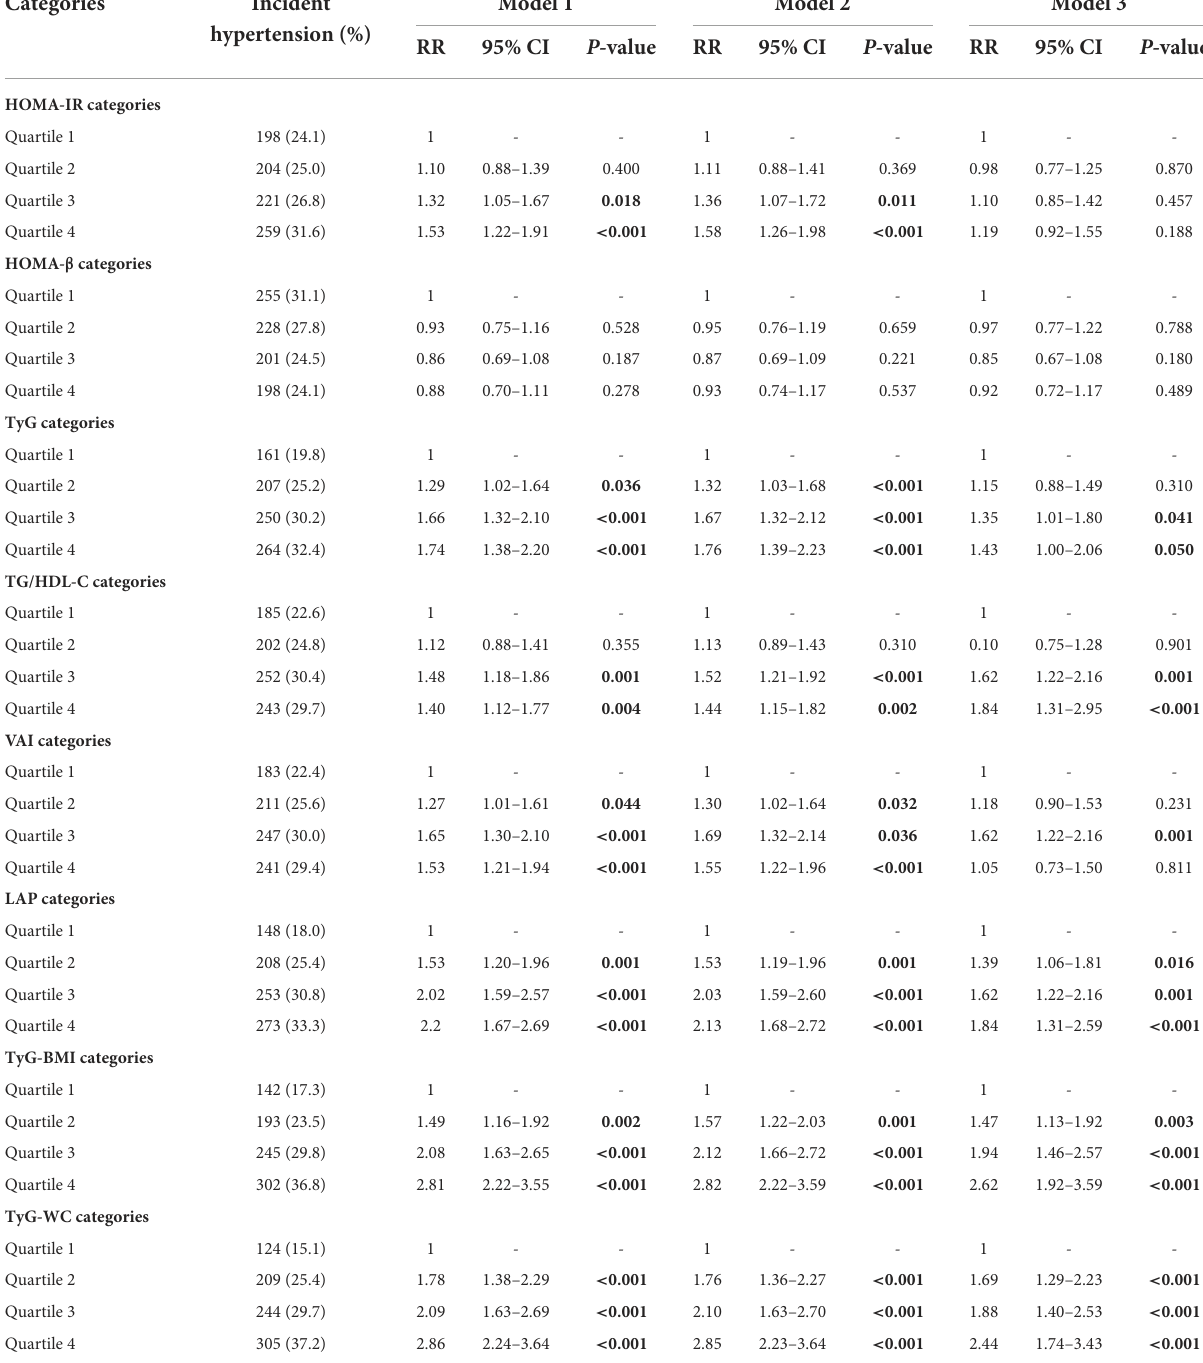
TABLE 2 Risk ratios and 95% confidence intervals of the association of IR categories and its surrogate index with incident